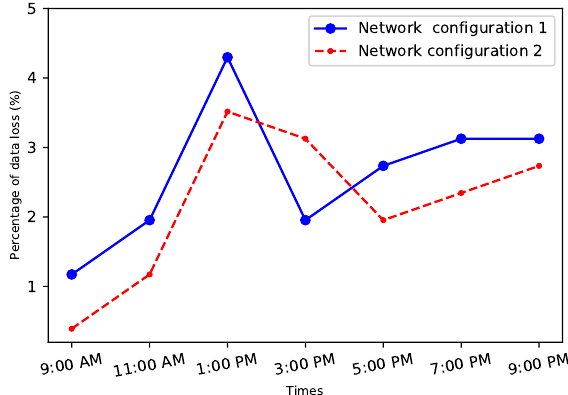
Figure 4. Percentage of data loss at different time